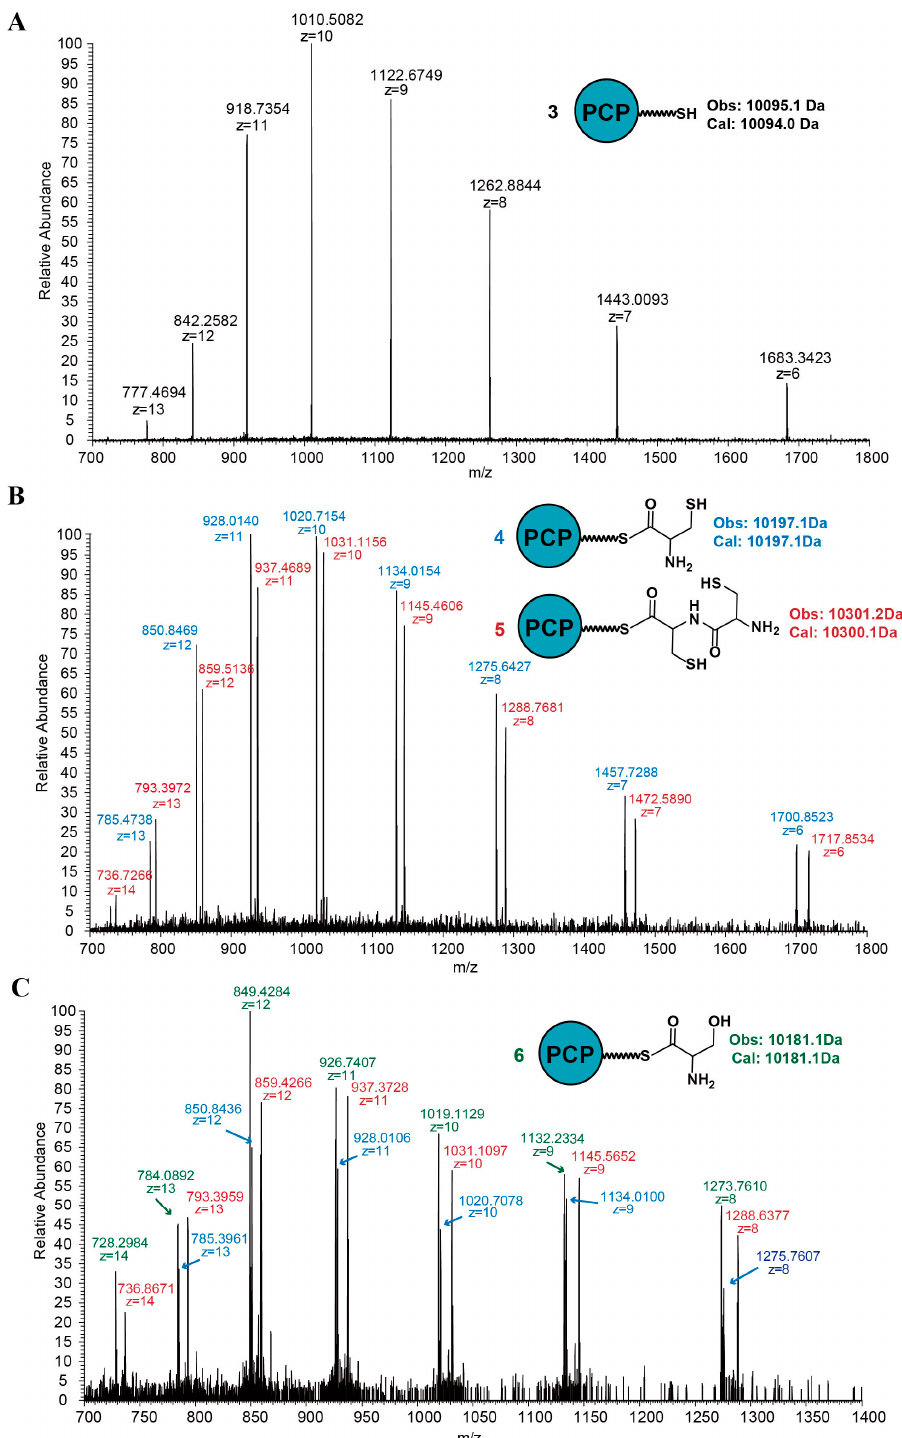
Figure 4. MS spectrum of products from amino acid loading assays with DtpB-PCP after TEV digestion. MS mass/charge ( m / z ) envelopes and mass deconvolution (Obs.) and expected mass (Exp.) are shown. ( A ) MS spectrum of holo -PCP domain from cysteine loading assay. ( B ) MS spectrum of single-cysteine-loaded PCP domain and Cys–Cys dipeptide-loaded PCP domain from cysteine loading assay. ( C ) MS spectrum of three different products from mixed substrates loading assay. Single-cysteine-loaded PCP domain, Cys–Cys dipeptide-loaded PCP domain, and single-serine-loaded PCP domain were observed.